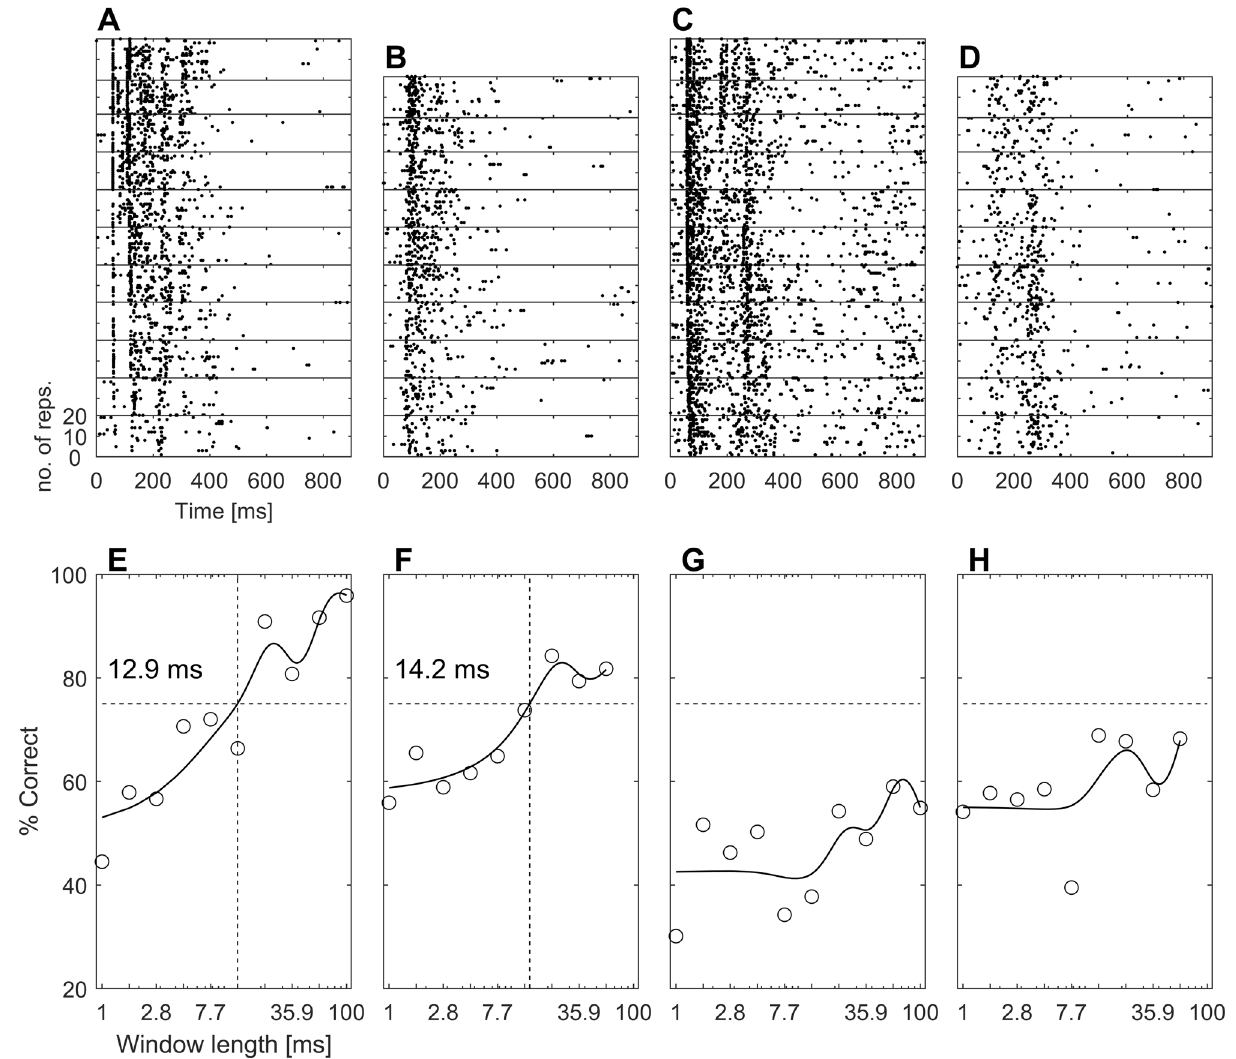
Figure 6. Raster plots and neurometric functions of four exemplary cortical neurons presented with phase- randomized aggression calls. ( A–D) Each block within the spike raster plot shows neuronal responses to one (increasingly phase-randomized) version of the stimulus. For the topmost block, the original call was presented, and for the bottommost block, the respective degraded version with the longest phase-randomization window was presented, respectively. Note that the number of phase-randomization steps varied with call length. Each stimulus version was presented 20 times in total. The unit in A and C shows a distinct temporal response pattern, the unit in ( B,D ) shows a more tonic response pattern. ( E,F) Neurometric functions as obtained from ROC analysis show significant discrimination performance by the two units from A-B and yield discrimination thresholds of 12.9 ms and 14.2 ms, respectively. ( G,H) Neurometric functions show no significant discrimination performance by the two units from ( C , D